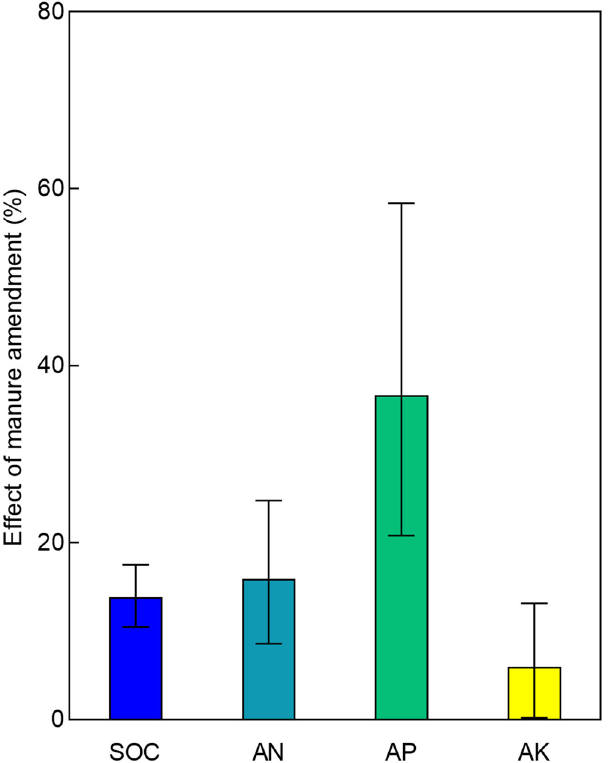
Fig. 4 Results from a meta-analysis investigating the effect of long-term manure amendment on soil fertility. SOC soil organic carbon concentration ( n = 39); AN available N concentration ( n = 30), AP available P concentration ( n = 37); AK available K concentration ( n = 31). Error bars represent 95% con fi dence intervals.